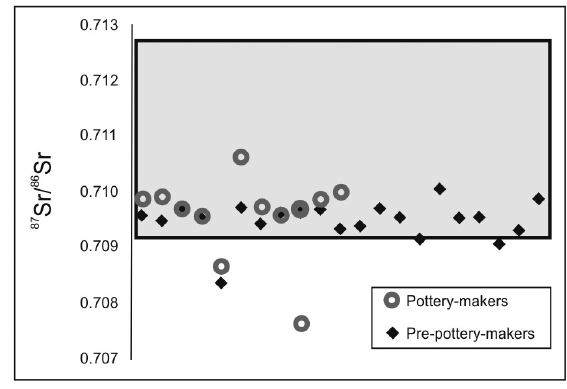
Fig. 1 – Relationship between the strontium isotope ratios for indi- viduals from the archeological sequence with pottery (pottery-makers) and without pottery (pre-pottery-makers) and the range of the local biological signature. The lower limit set for the local biological signa- ture is also the present marine strontium ratio.